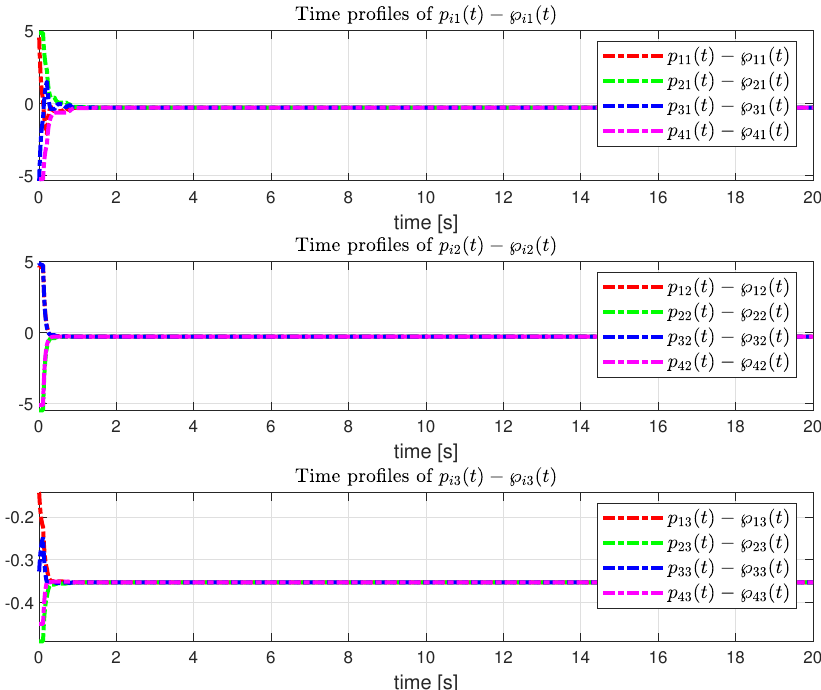
Figure 5. Performance of the pseudo position estimator.